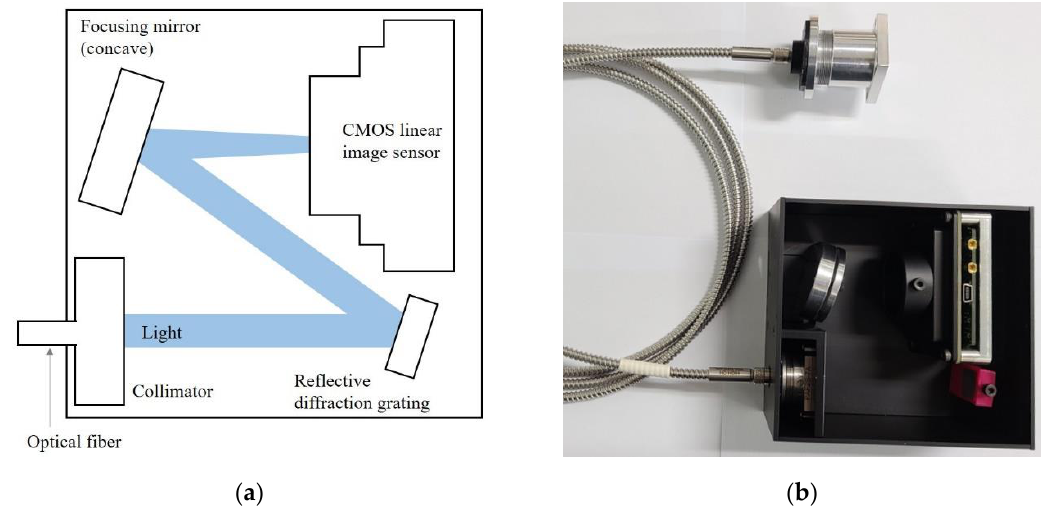
Figure 1. Configuration of the developed spectrometer: ( a ) schematic; ( b ) designed prototype.